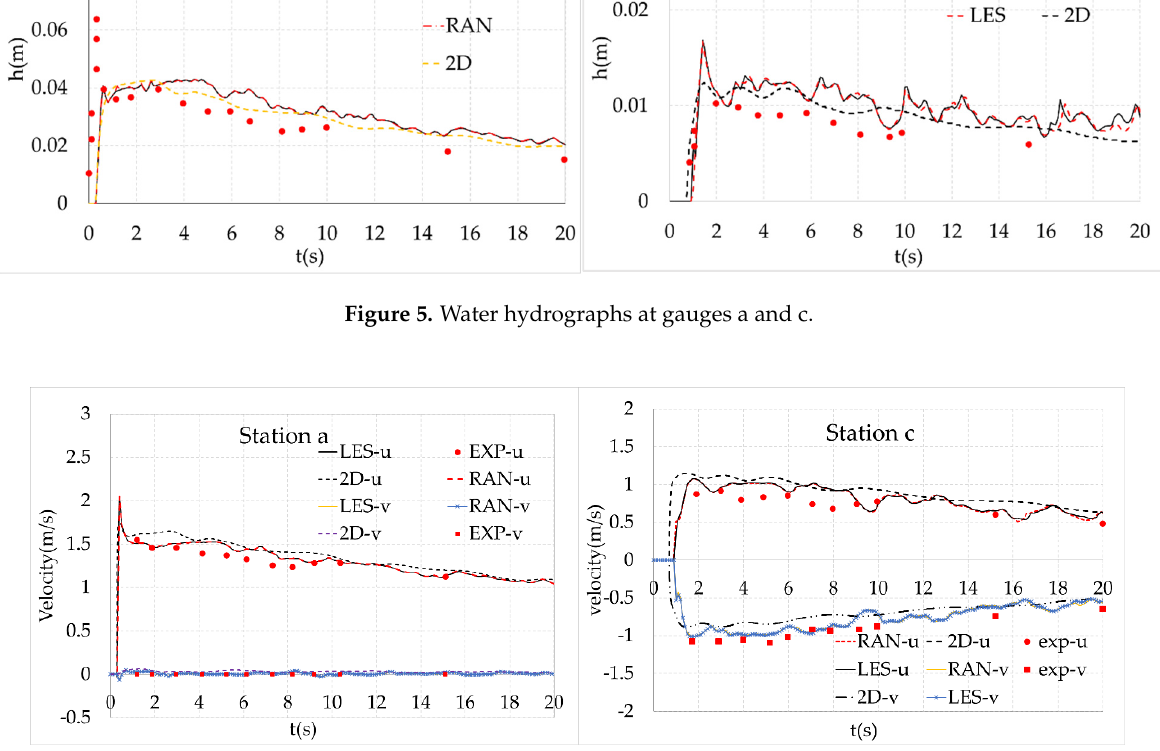
Figure 6. Velocity component profiles at gauges a and c.